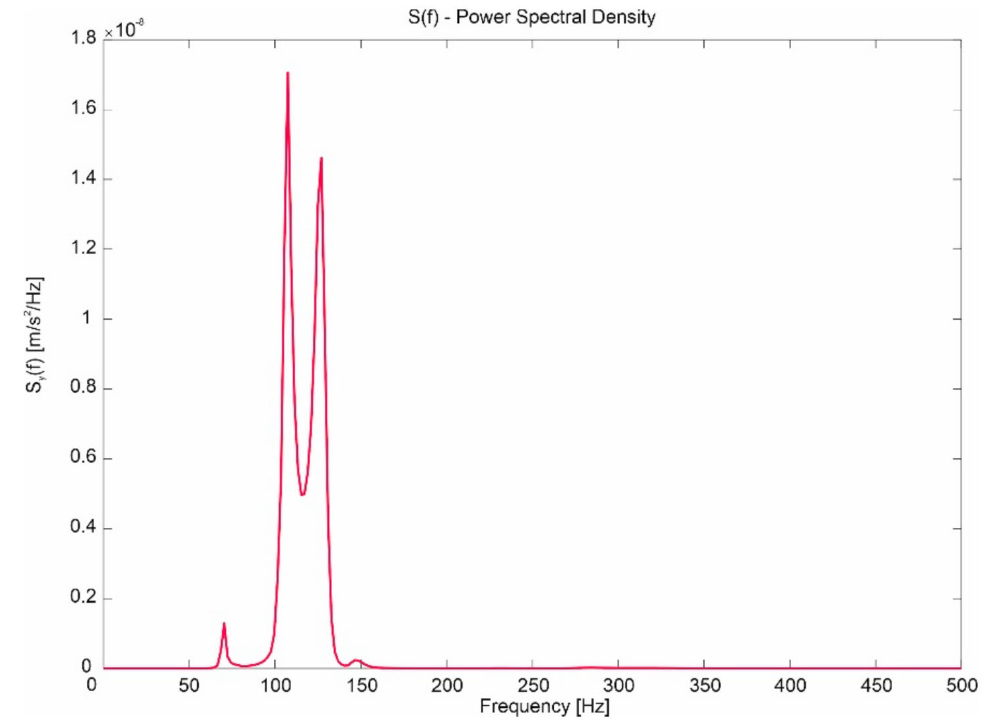
Figure29. Spectrumgeneratedfromaccelerationonthelevitationsysteminthedirection y for2000km /